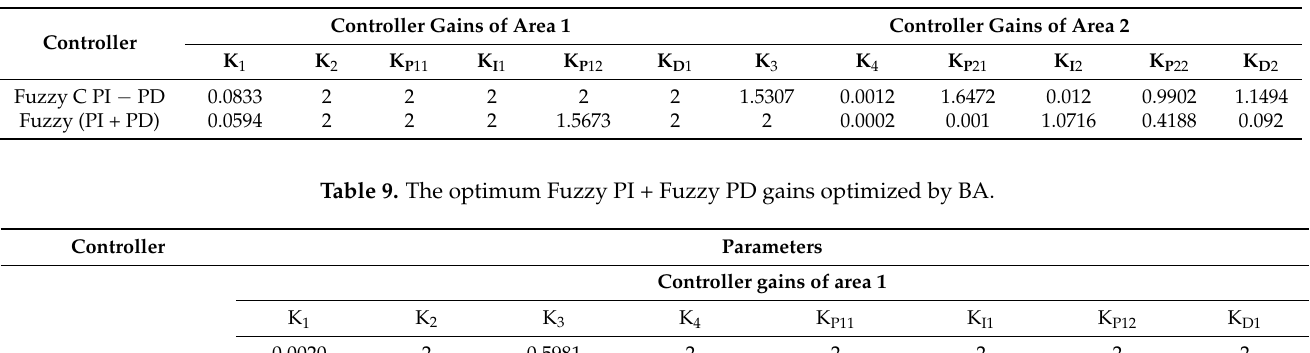
Table 8. The optimum values of the proposed Fuzzy C PI − PD and Fuzzy (PI + PD) controllers obtained by the BA.